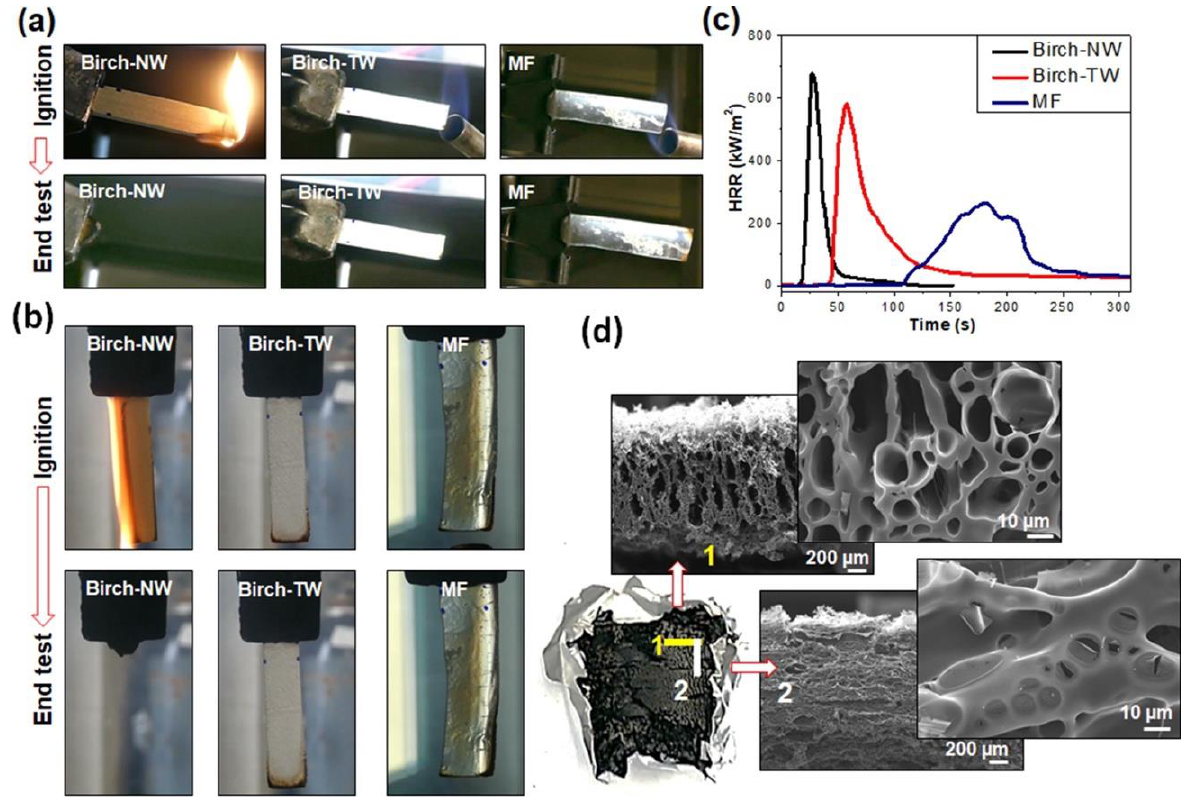
Figure 38. Flame spread test snapshots ( a ) in horizontal, ( b ) in vertical configuration, and ( c ) heat release rate vs. time curves for pristine birch wood (Birch-NW), flame-retardant birch wood (Birch-TW), and cured melamine – formaldehyde resin (MF); ( d ) cross-section SEM micrographs of the residues of Birch-TW in two perpendicularly oriented planes. Reprinted from [50] under CC-BY license.